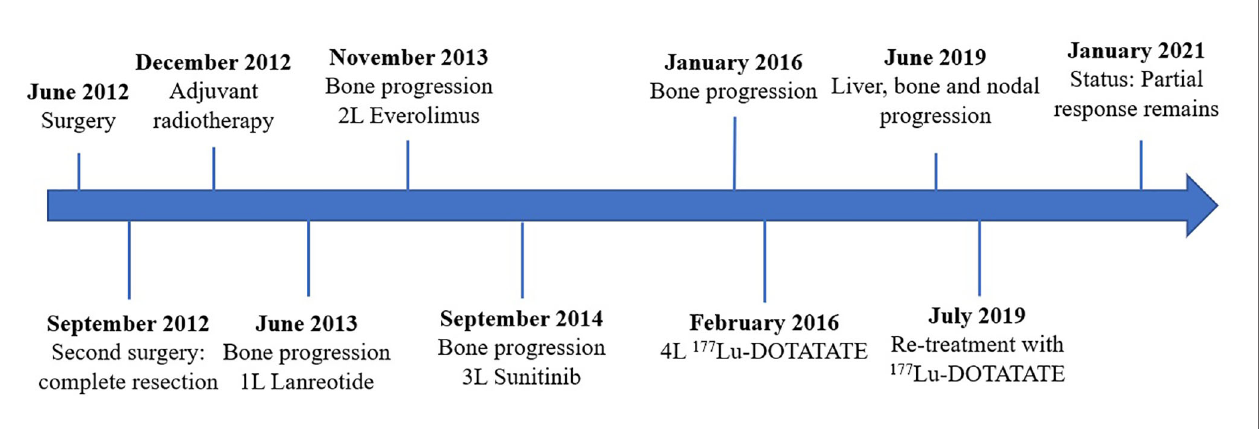
FIGURE 3 | Historic evolution of the